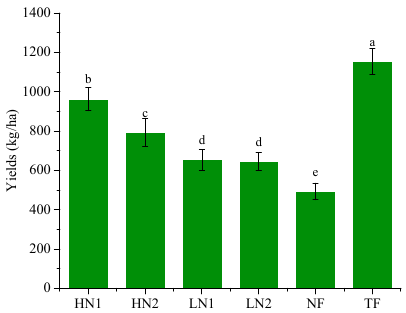
Figure 1. Yields with different N supplies. The statistical approach used was LSD (least significant difference) analysis. Every group contains 3 tea leaf samples. Different lower-case letters above the bars indicate significant differences among treatments ( p < 0.05 ).